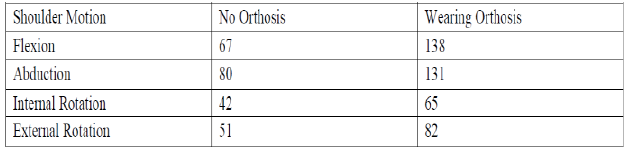
Table 1. Active range of motion at the shoulder, with no orthosis and while wearing